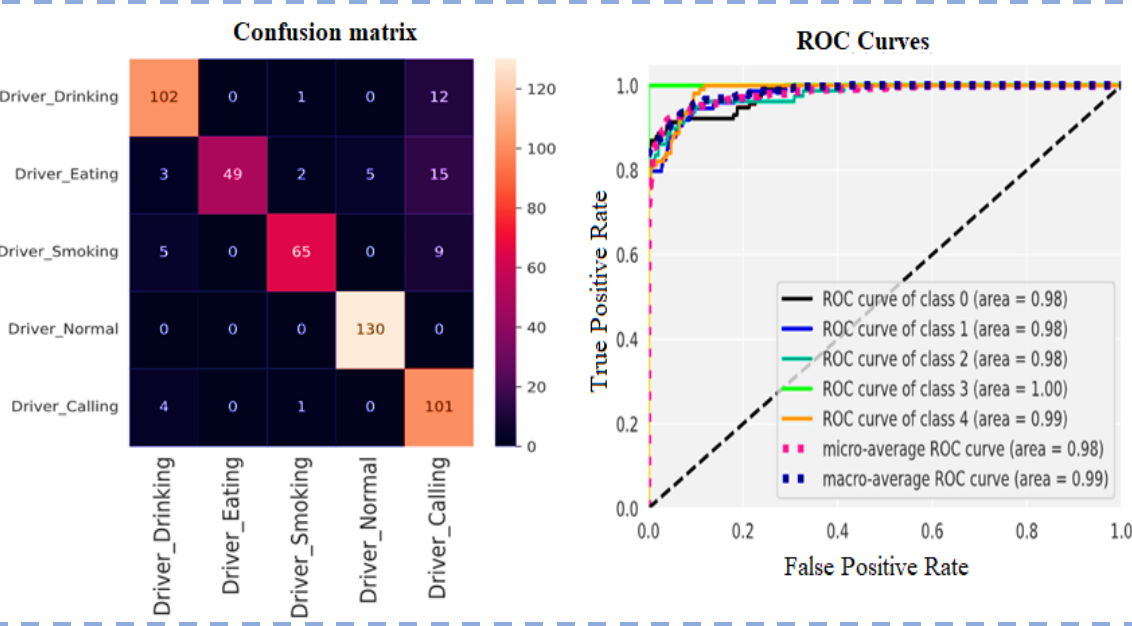
Figure 7. Confusion matrix and ROC Curves using ResNet101.